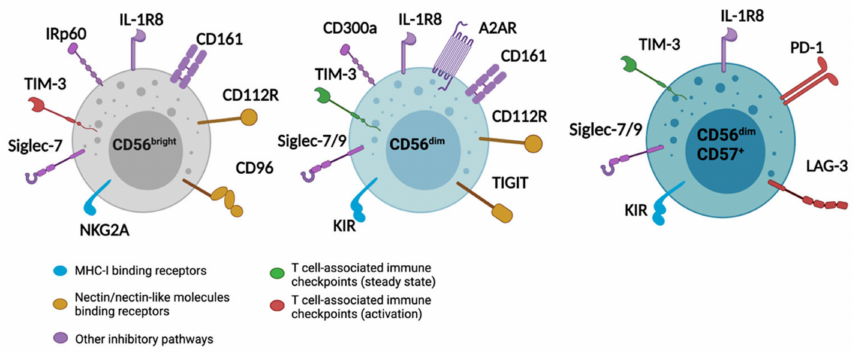
Figure 1. Differential expression of inhibitory receptors NK cell subsets. Immature CD56 bright , mature CD56 dim , and terminally differentiated CD56 dim CD57 + NK cells are regulated by different inhibitory receptors. MHC-I binding receptors are represented in blue, receptors binding to nectin/nectin-like molecules binding are in yellow, T cell-associated immune checkpoints expressed in steady state are in green, T cell-associated immune checkpoints up-regulated upon activation are in red, and other inhibitory pathways are shown in